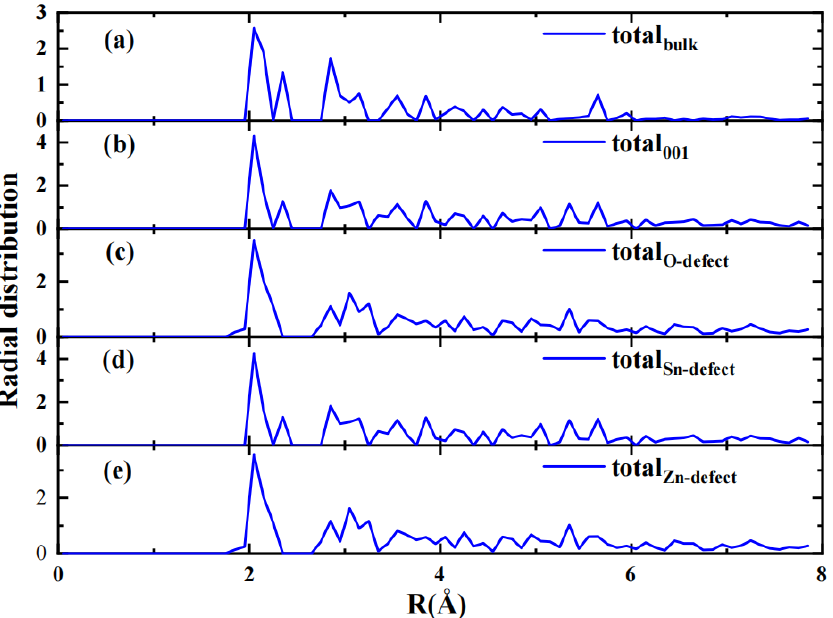
Figure 1. Radial distribution functions of ZnSnO 3 . ( a ) bulk; ( b ) perfect 001 surface; ( c ) V O surface; ( d ) V Sn surface; ( e ) V Zn surface.